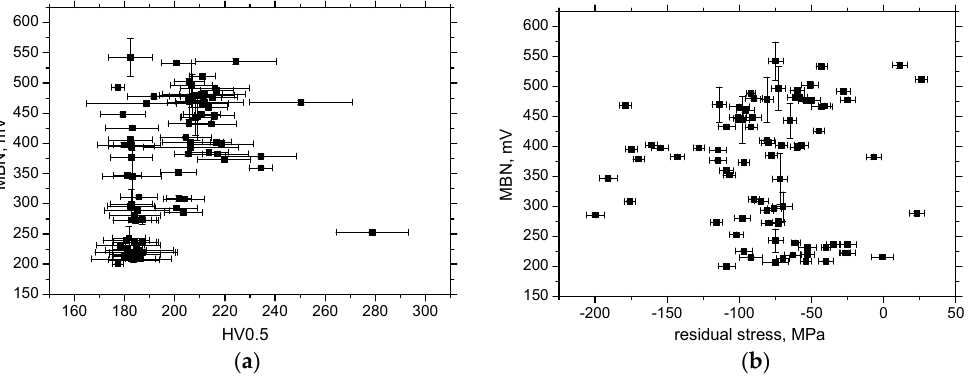
Figure 20. Correlations for MBN, TD. ( a ) MBN versus HV0.5; ( b ) MBN versus residual stresses.